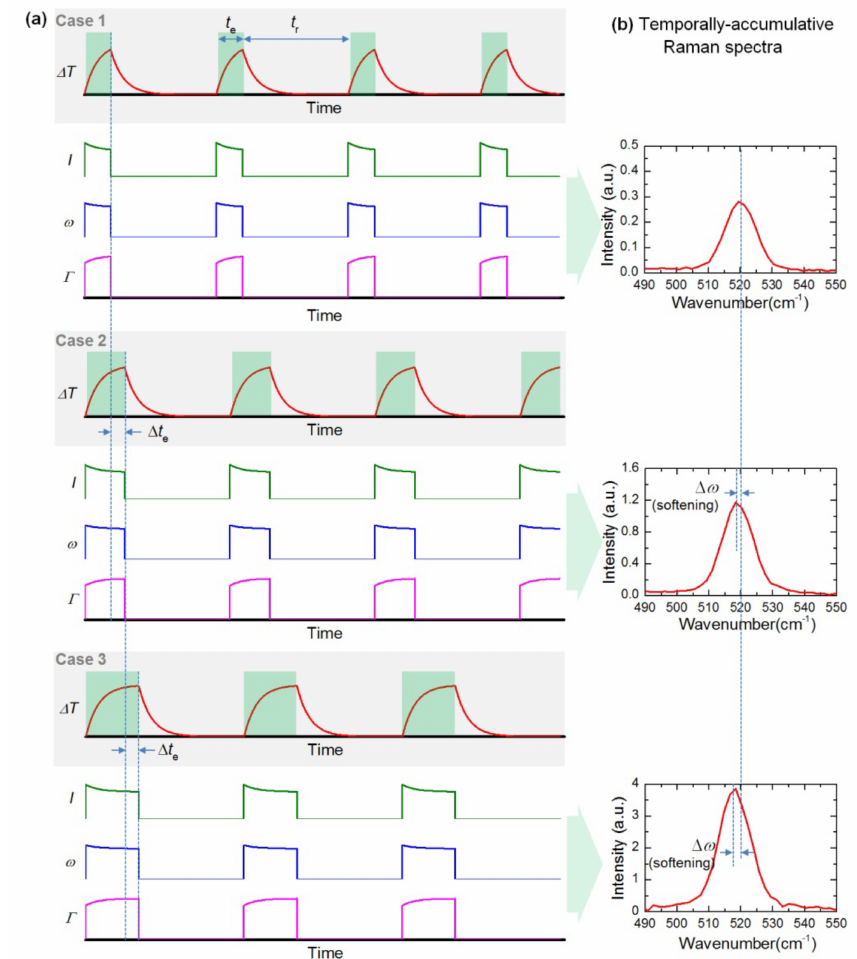
Figure 6. Concept of TD − Raman. ( a ) The change of temperature evolution( ∆ T), and instant changes of Raman peak intensity (I), peak shift ( ω ) and linewidth ( Γ ). ( b ) The corresponding temporally accumulative Raman spectra of one laser pulse cycle in Case 1, 2, and 3. Reprinted with permission from Ref. [48] © The Optical Society. Copyright 2015, The Optical